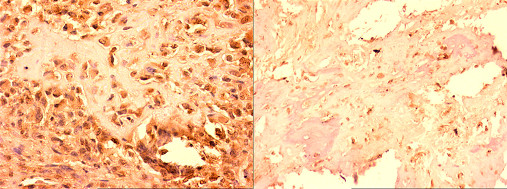
VEGF expression in osteosarcoma before and after chemotherapy. Pre-chemotherapy biopsy (×200) and post-chemotherapy resection specimens (×600) showing immunostaining for VEGF.